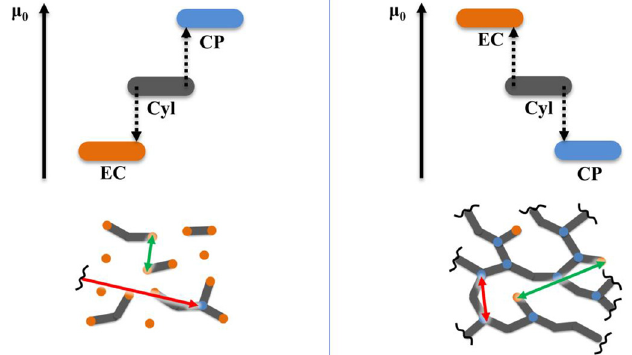
Fig. 2. The in fl uence of standard reference chemical potential on microstructure (two extreme